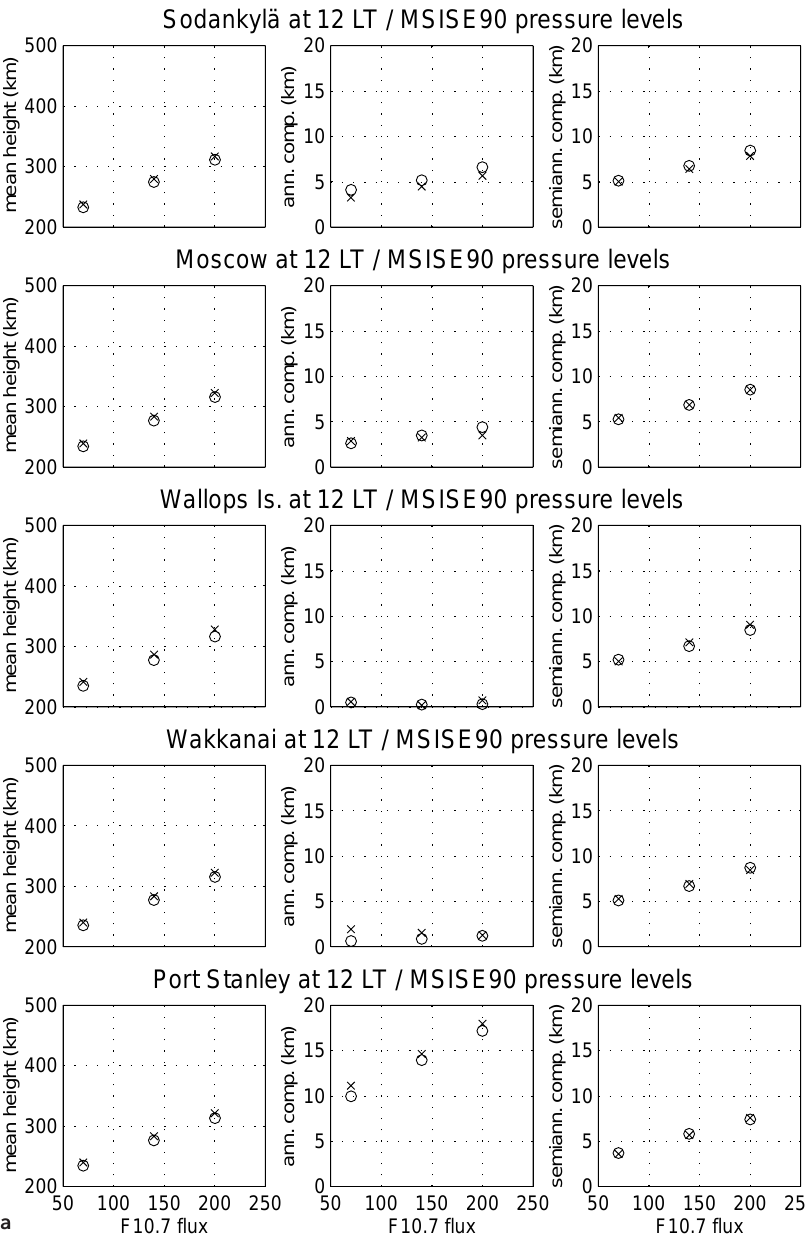
Fig. 7. a Annual means, annual and semi- annual amplitudes of the fixed pressure-level 20 l Pa (approximately corresponding to daytime h mF2) plotted versus 10.7 cm solar flux at five stations for noon (12 LT). b Annual means, annual and semiannual amplitudes of the fixed pressure-level 2 l Pa (approximately corresponding to nighttime h mF2) plotted versus 10.7 cm solar flux at five stations for night